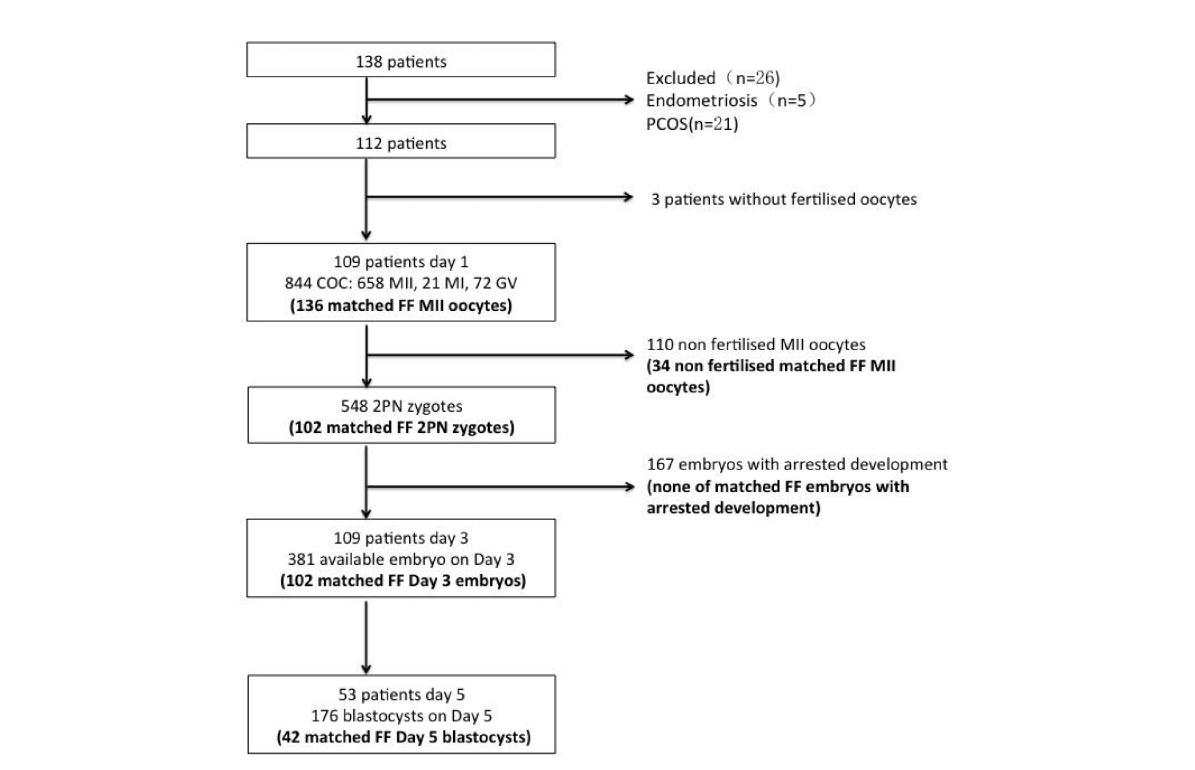
FIGURE 1 Flowchart of participants, oocytes, embryos and embryo transfer procedure in the study. FF — follicular fl uid; COC — cumulus – oocyte complex, GV — germinal vesicle, MI immature metaphase I oocyte; MII — mature metaphase II oocyte; 2PN — 2 pronuclear zygote; matched FF — embryo developed from an oocyte that has matched the FF sample in the study; TQ — top